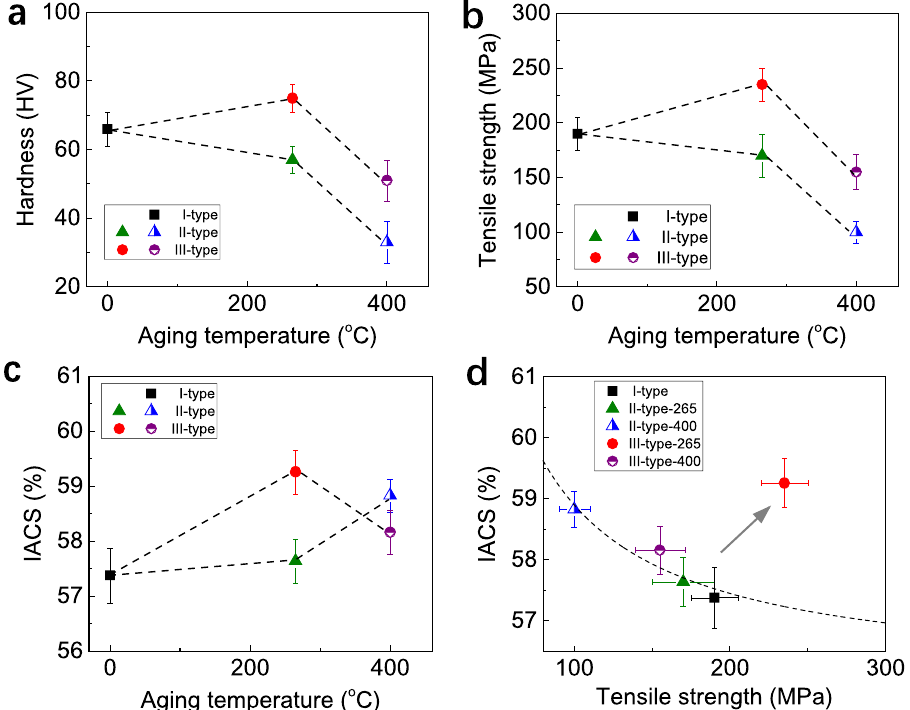
Figure 4. Hardness, tensile strength, and electrical conductivity of the Al-Zr conductors with different processing routes. Experimentally measured hardness ( a ), tensile strength ( b ), and electrical conductivity ( c ) of the Al-Zr conductors under different processing routes and different aging temperature (265 and 400 °C). ( d ) Electrical conductivity vs tensile strength of present Al-Zr conductors. The III-type-265 Al-Zr one clearly stands out, above and beyond the trend (represented by the dash curve) for the normal trade-off between strength and